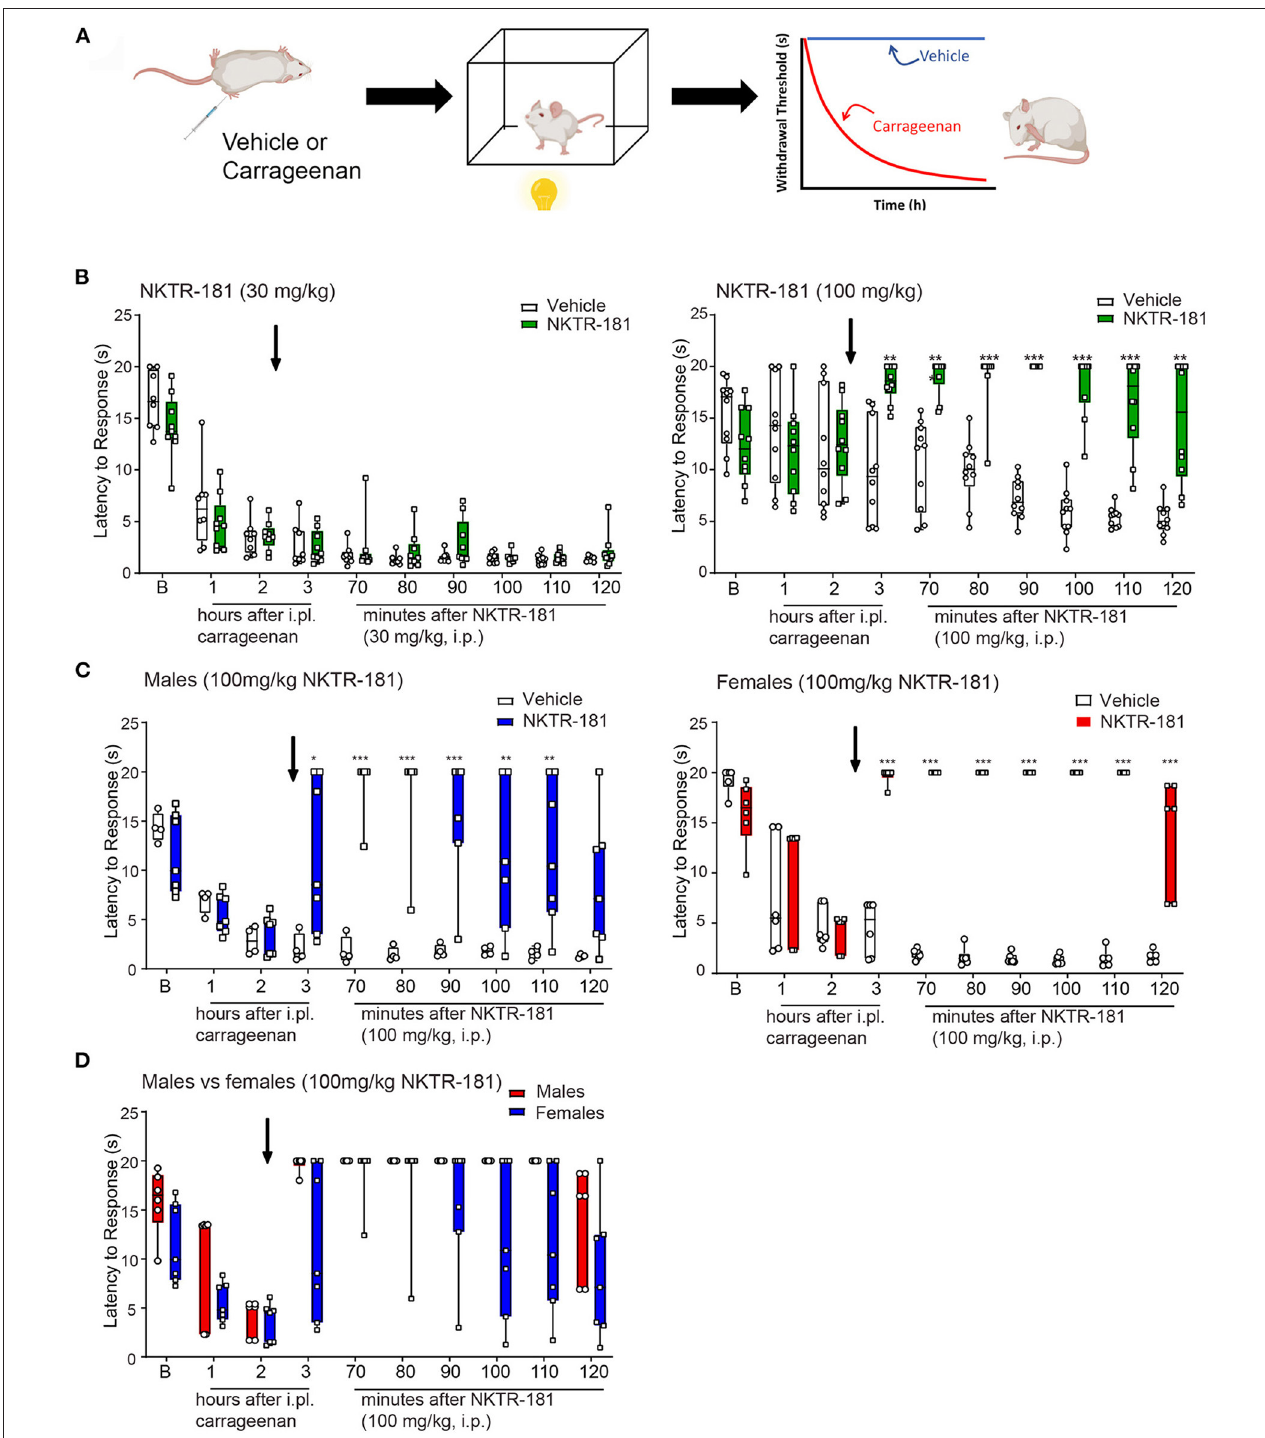
FIGURE 7 | Anti-hyperalgesic effects of NKTR-181 in the thermal plantar test following an i.pl. injection of carrageenan. (A) Schematic image of a protocol. Mice received an i.pl. injection of carrageenan (2%) into the left hindpaw. Baseline latencies were acquired prior to injection, and mice were tested once an hour for 3h. To evaluate effectiveness of the opioid, NKTR-181 was injected after the 2nd h due to its delayed effectiveness. Following drug or vehicle injection, mice were tested every 10min for 1h. (B) I.pl. carrageenan injection and systemic vehicle significantly reduced thermal withdrawal thresholds. NKTR-181 (100, but not 30 mg/kg, i.pl.) significantly increased thermal thresholds following i.pl. carrageenan. * p < 0.05, ** p < 0.01, *** p < 0.001. (C,D) Data from the higher dose of NKTR-181 in panel b were divided by sex. NKTR-181 produced anti-hyperalgesic effects in both males and females, but with no effect of gender. All raw data are presented as box plots with minimum to maximum points. Refer to Supplementary Table 3 for